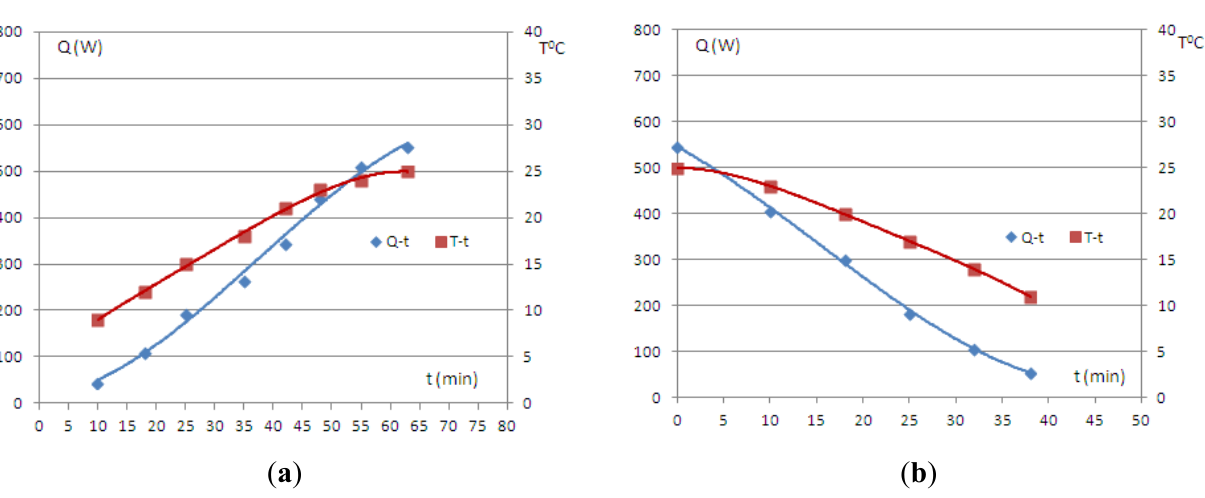
Figure 5. Heat fluxes and air outlet temperatures variation in times, in a sunny day in January: ( a ) heating process; ( b ) cooling process.